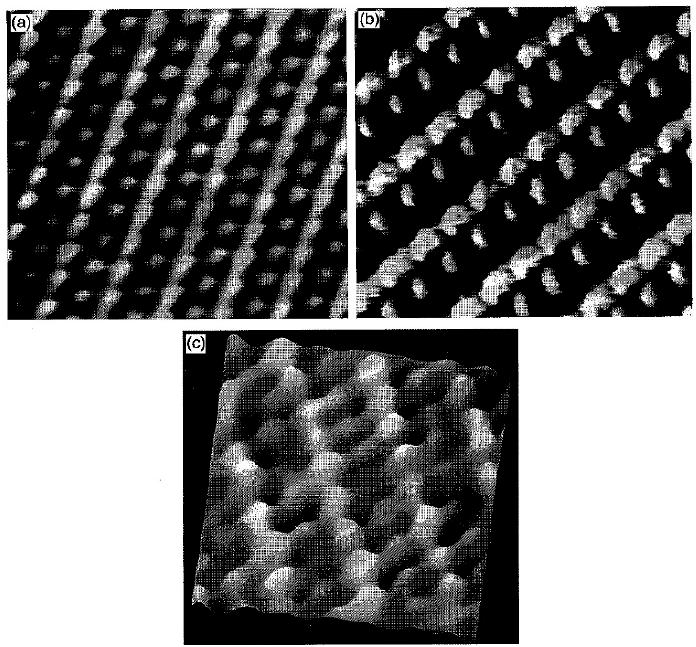
Figure 2. ( a ) Te-layer-like scanning tunneling microscopy (STM) image of WTe 2 (001) surface; ( b ) W-layer-like STM image of WTe 2 (001) surface; ( c ) Corresponding atomic force microscopy (AFM) image (lateral force mode) [17], with copyright permission from ©